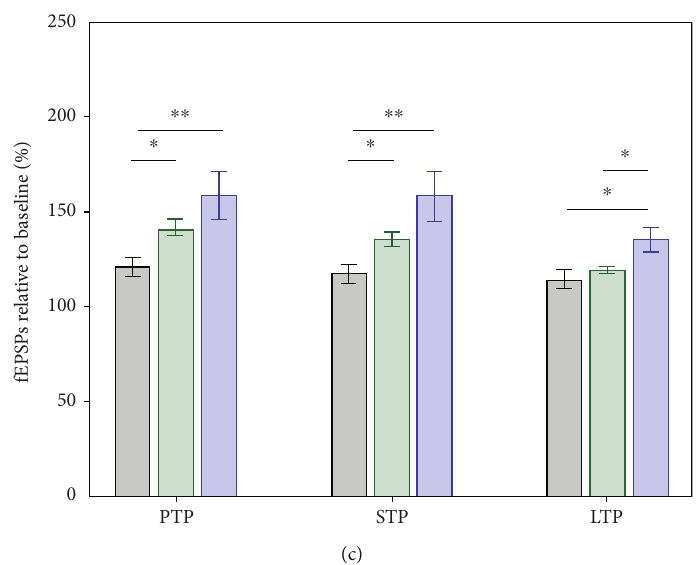
Figure 4: LTP response to di ff erent trains of the TBS protocol in Sprague-Dawley rats. As the number of TBS trains were increased, the LTP response increased in the SD rats. (a) Average input/output curves between stimulation voltage and fEPSP slope overlap for the study groups indicating no di ff erence in basal synaptic excitability. (b) fEPSPs were enhanced compared to baseline following 2 trains of TBS (black, n = 8 ), 5 trains of TBS (green, n = 7 ), and 10 trains of TBS (blue, n = 6 ); as the number of trains were increased, the larger was the fEPSP increase. LTP response induced by 10 × TBS was signi fi cantly higher than both 2 × TBS and 5 × TBS throughout the whole 2-hour posttetanisation. Data are presented as means ± 95 % confidence intervals . Outsets above LTP curves represent average waveform fi eld potentials during 30min baseline prior to tetanisation and 0-30min and 90-120 min posttetanisation. Horizontal bar: 1 mV; vertical bar: 5ms. (c) PTP, STP, and LTP responses are presented as means ± 95 % confidence intervals . ∗ p value < 0 : 05 and ∗∗ p value < 0 : 01